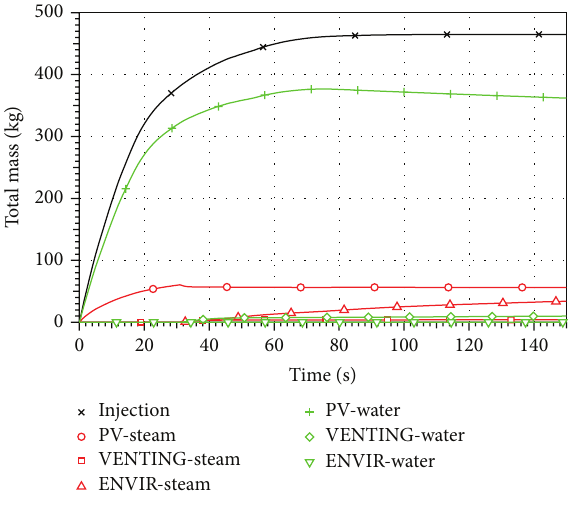
Figure 11: Base case scenario: the mass balance.